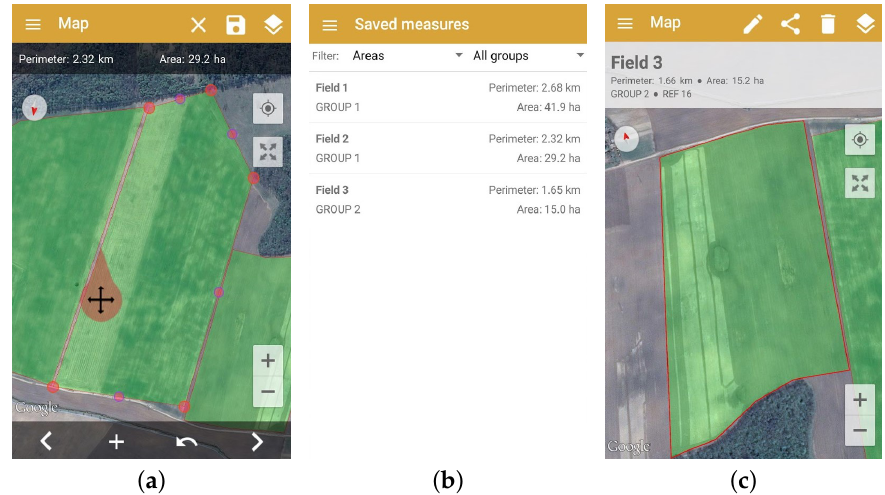
Figure 32. GPS Fields Area Measure: ( a ) Field boundary setting using GPS coordinates; ( b ) History of saved measures; ( c ) Field measurement